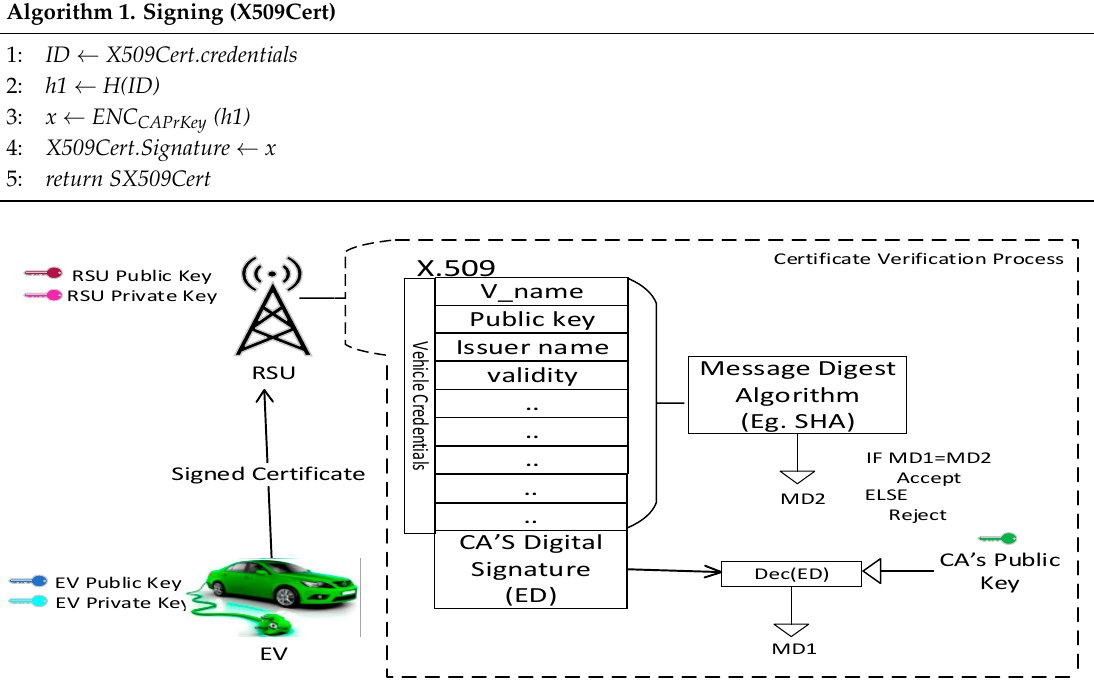
Figure 5 . Certificate verification of EV by road side unit (RSU). Figure 5. Certificate verification of EV by road side unit